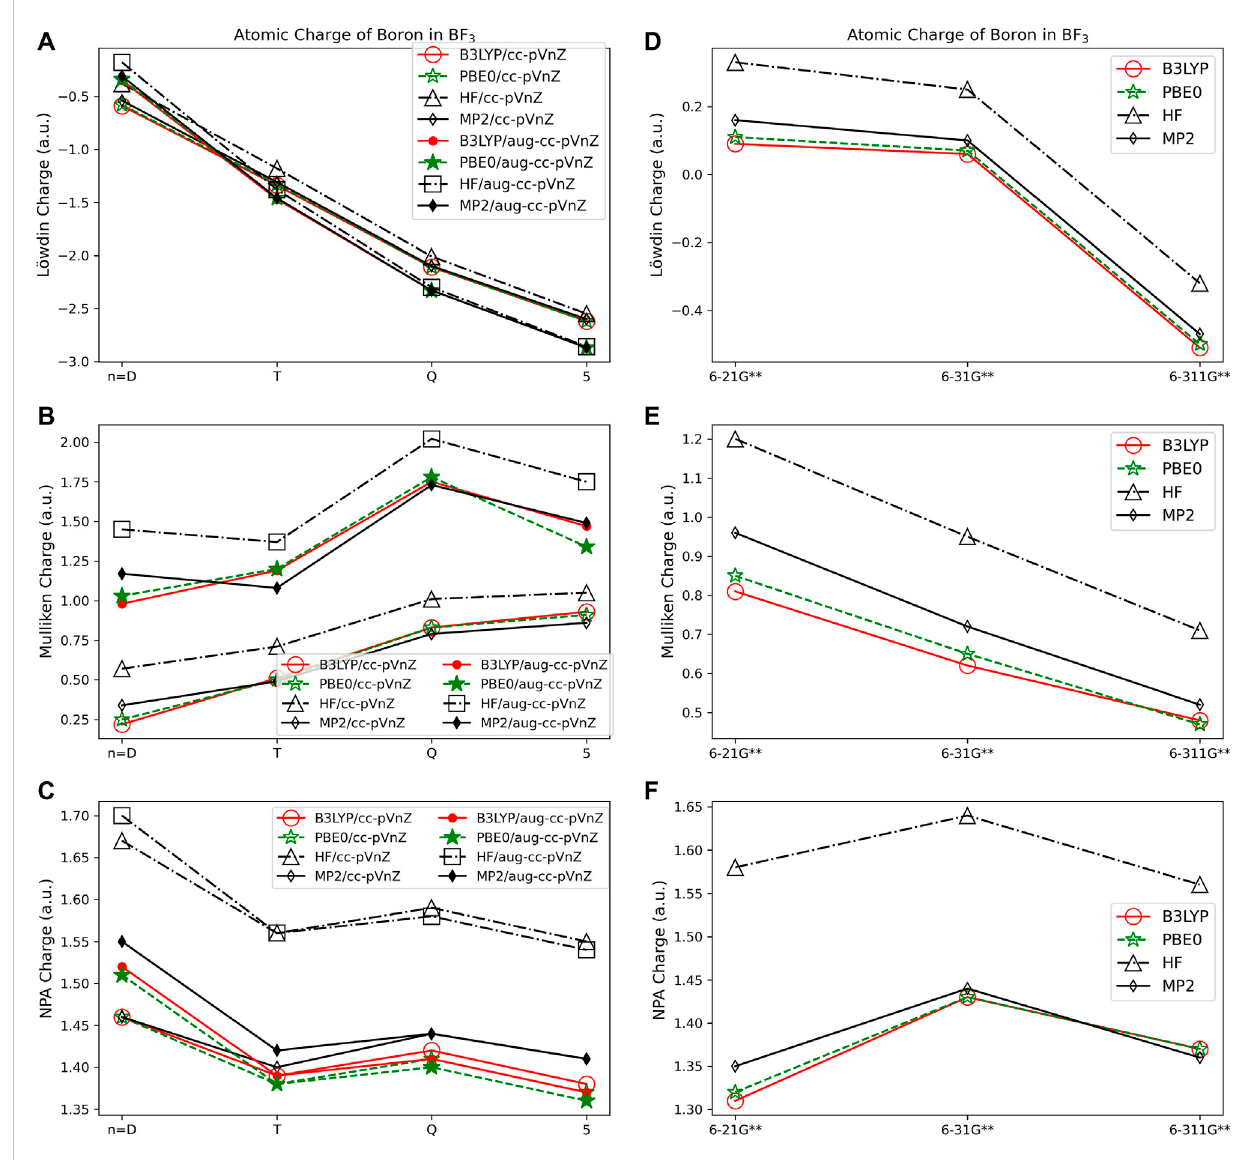
FIGURE 4 Atomic charge of boron in BF 3 determined using a number of different theoretical methods, Dunning style basis sets, and wavefunction-based populationanalysismethods: (A) Löwdin, (B) Mulliken,and (C) NPA.(*Notethatscalesvaryfromoneanalysismethodtoanother.)Poplestylebasissetsare presented in (D) Löwdin, (E) Mulliken, and (F)